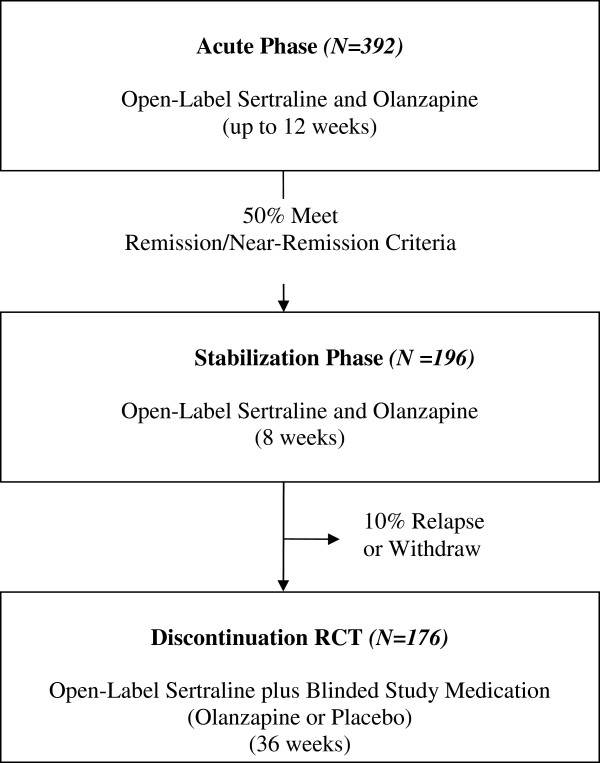
STOP-PD II: study design and subject flow.